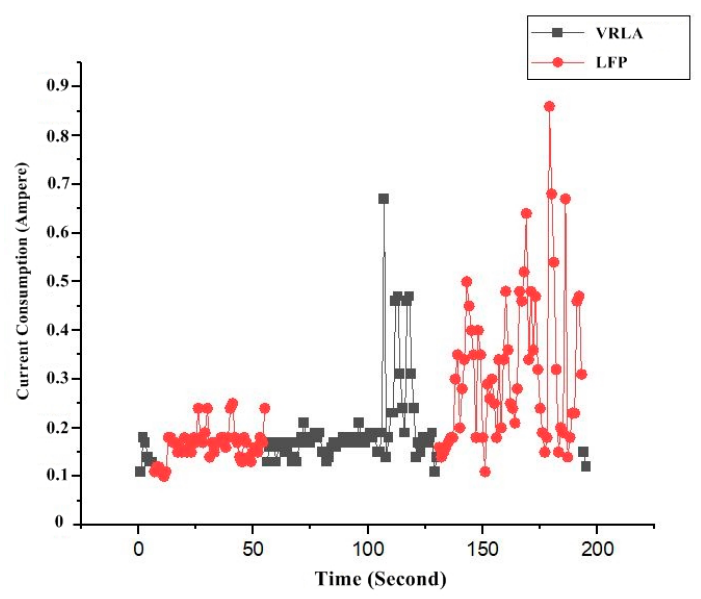
Figure 19. Dual battery current consumption of VRLA and LFP graph.